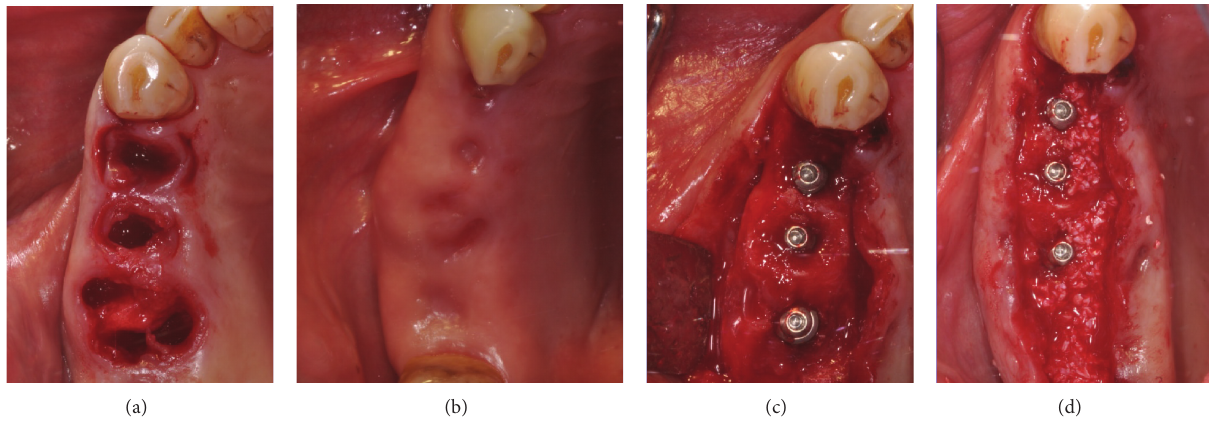
Figure 5: Type 2 implant positioning with simultaneous GBR technique: (a) extraction time point, (b) 4-week clinical soft tissue healing condition, (c) implant insertion, and (d) simultaneous GBR to optimize bone volume.